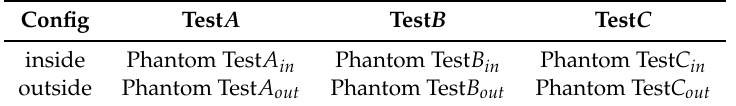
Table 1. Configuration of PE granules filler low-contrast Test A , Test B , and Test C phantoms.